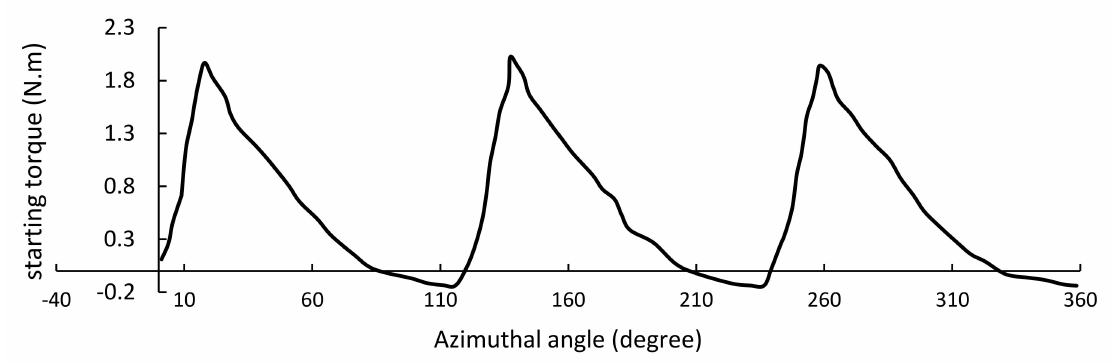
Figure 16. Starting torque of wind turbine with different pitch angles in the rotor plan.